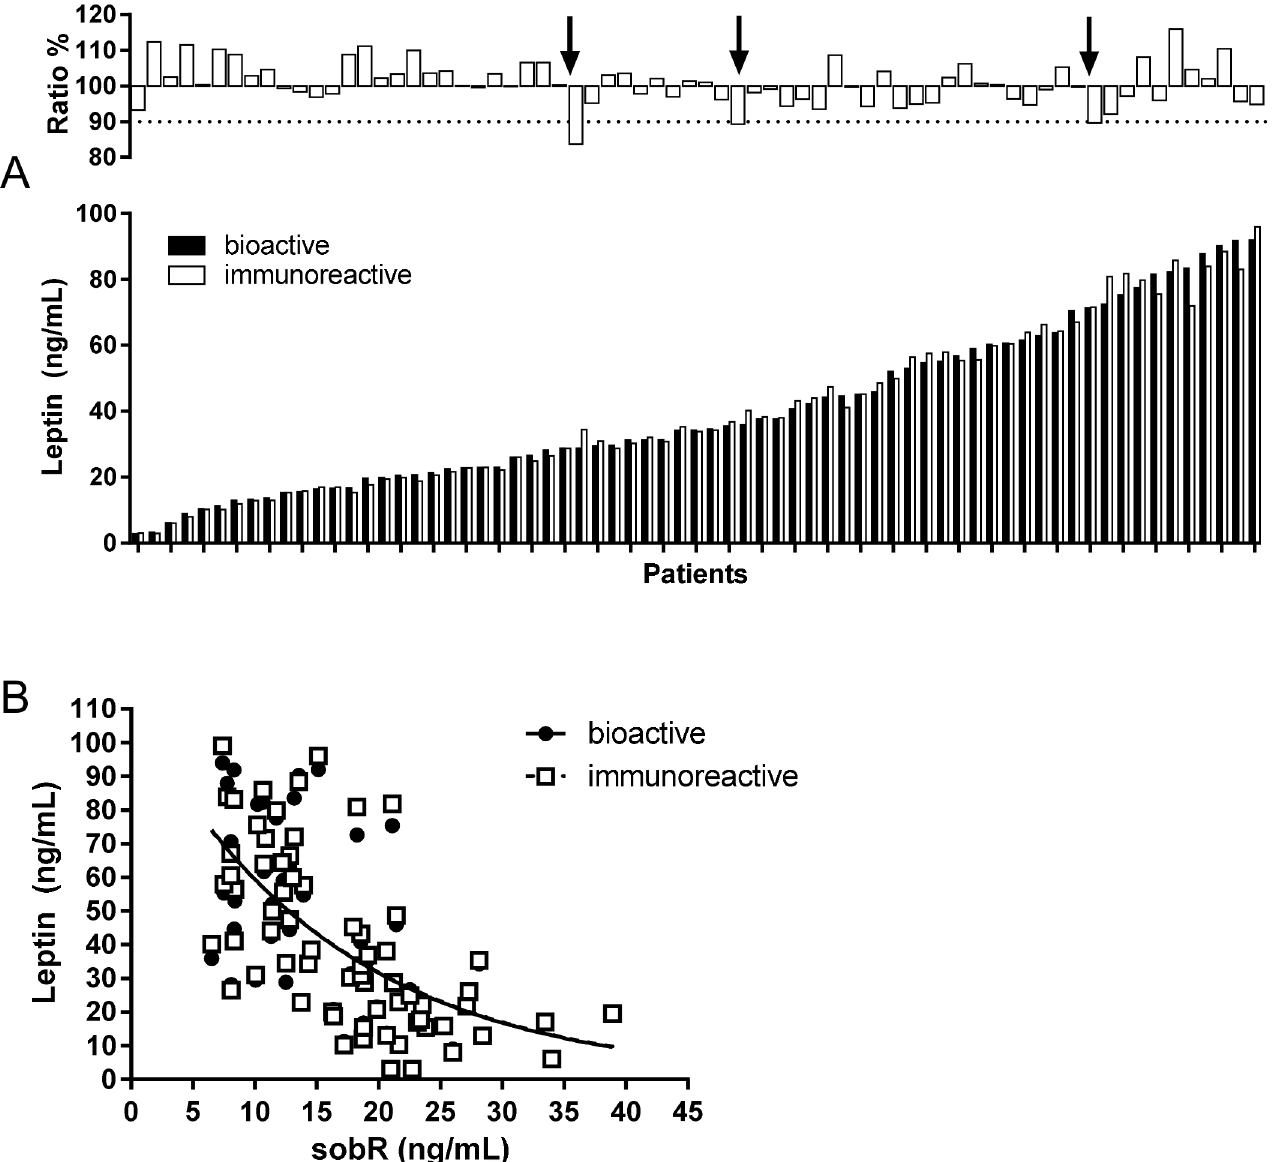
Fig 1. Distribution of bioactive and immunoreactive leptin levels. A–the range of bioactiveand immunoreactive leptin for individualpatients is shown as indicated(lower part). Ratio betweenboth forms rangedaround100% with few patients lower than 90% (upper part). B–Non-linear regression betweenbioactiveand immunoreactive leptin serum levels with solubleleptin receptor (sobR).